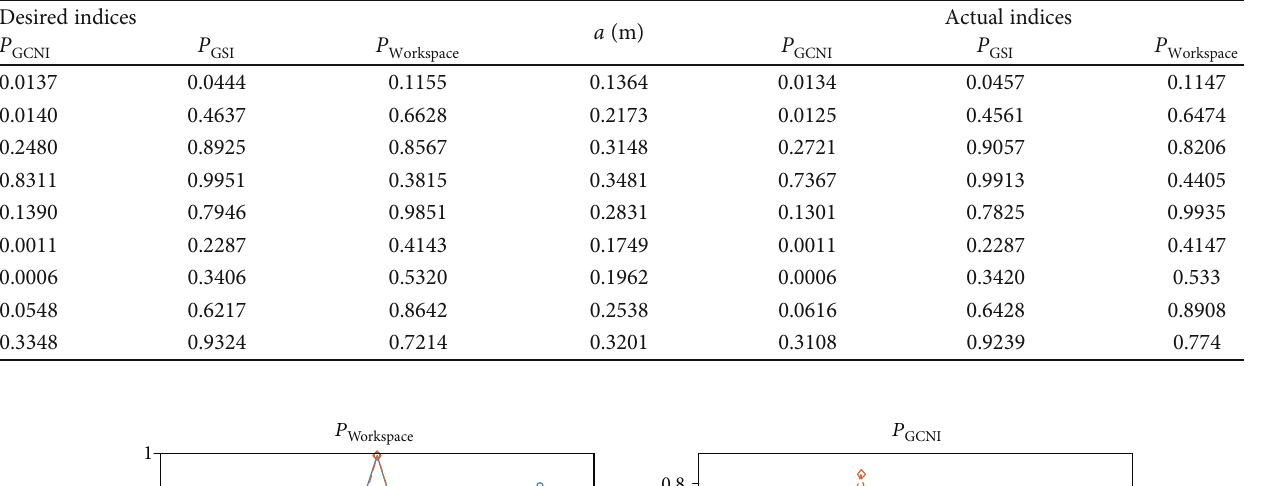
Table 2: The test and actual indices.